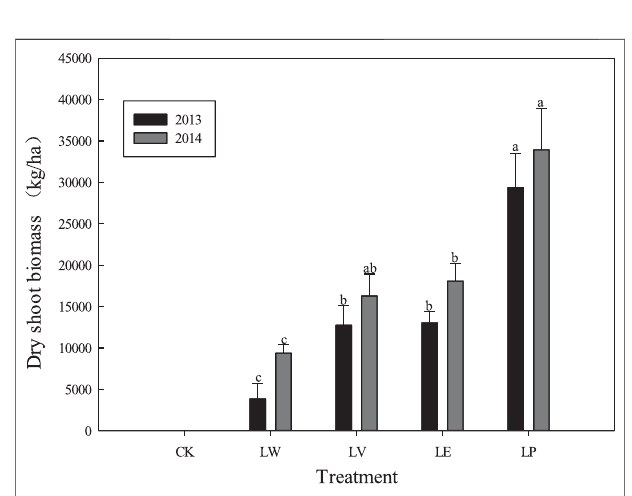
FIGURE 2 | Dry shoot biomass of each treatment (CK (cid:2) untreated soil, LW (cid:2) lime + Setaria lutescens , LE, lime + Elsholtzia splendens ; LV, lime + Vetiveria zizanioides ; LP, lime + Pennisetum sp ., Different lowercase letters indicate signi fi cant differences between treatments in the same year, n (cid:2) 3, p <